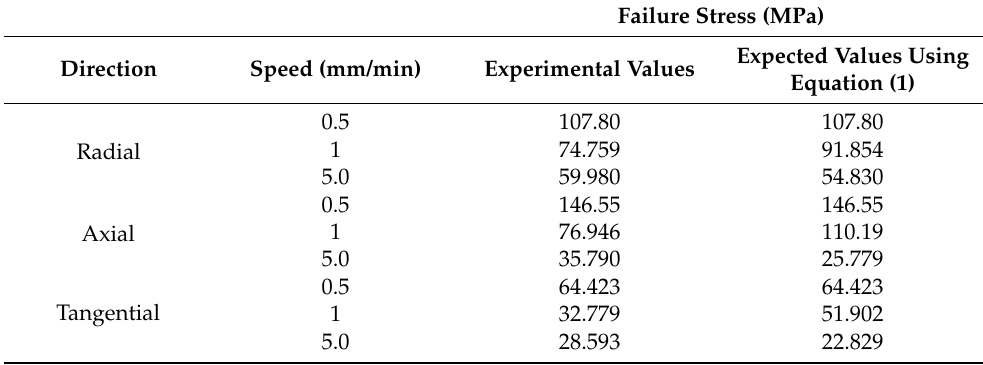
Table 1. Experimental and expected values using Equation (1) of the failure stresses for the three directions at three displacement rate values.